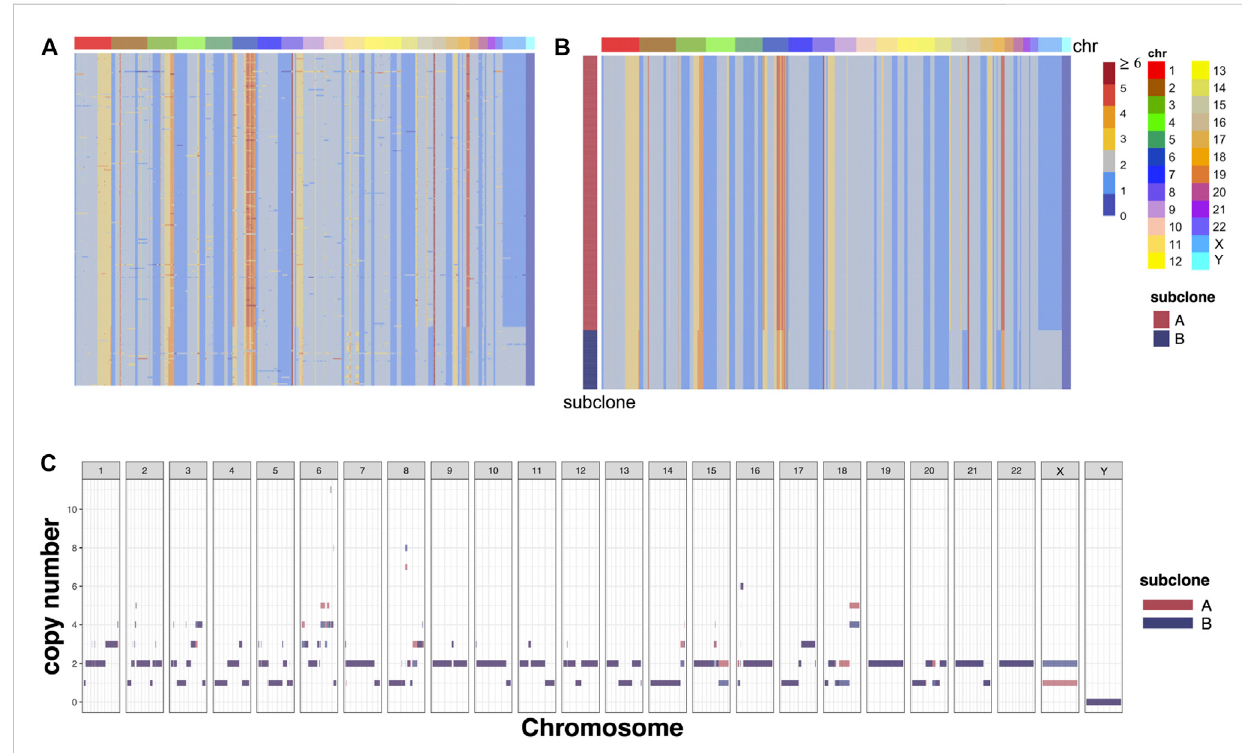
FIGURE 5 RobustTree reconstructs the tumor evolutionary tree on SA501X3F data. (A) Observed noisy CNA genotype matrix. (B) Recovered CNA genotype matrix by RobustTree. (C) Genotypes of subclones recovered by